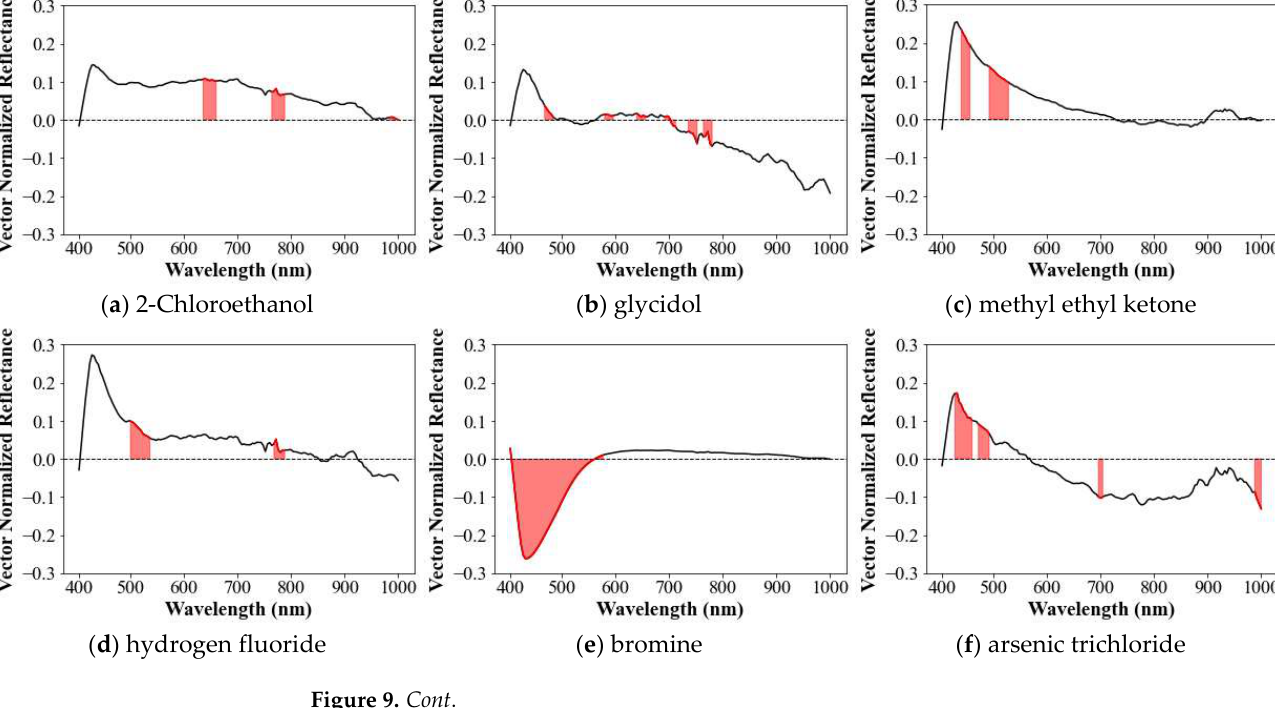
Figure 8. Characteristic spectral library of phosphorus trichloride (red color). ( a ) Primary characteristic spectral library of Phosphorus trichloride; ( b ) final characteristic spectral library of phosphorus trichloride.